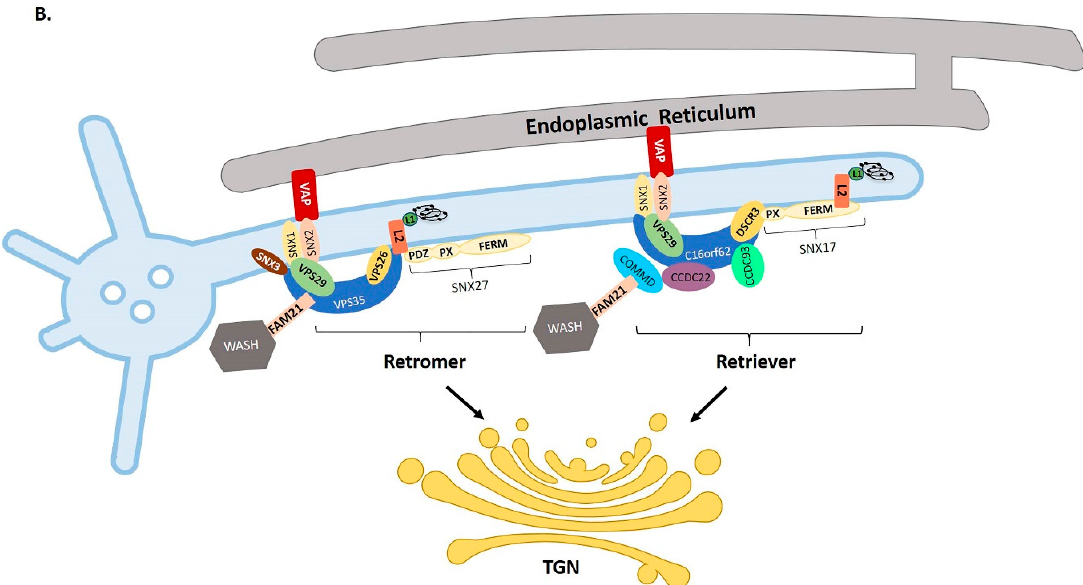
Figure 1. Schematic diagram of HPV intracellular trafficking to the TGN. ( A ) Following endocytosis, uncoating of papillomaviruses is triggered by acidification of the late endosome. Endosomes as they mature exhibit tubulation. L2/vDNA segregates from most of the L1, which is then degraded in the lysosome. L2/vDNA along with a small amount of L1 enters the TGN with the help of cellular sorting factors. The dashed box shows how the retromer and retriever complexes might cooperate in HPV infection, which is shown in more detail in panel B. ( B ) Prior to the entry of viral cargo to the TGN, L2 binds SNX27, retromer and SNX17 which is part of the retriever complex. The ER makes contact points with endosomes, Golgi and plasma membrane using integral ER VAP protein.